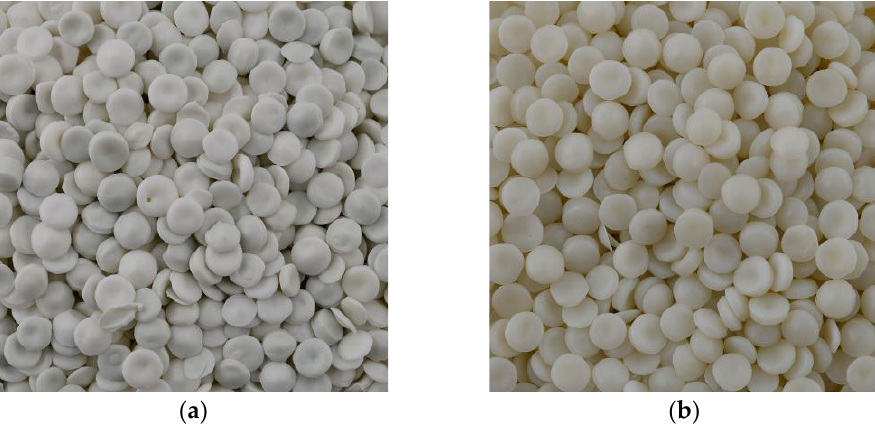
Figure 2. Images of the pellets of the PE-HD recyclates rPE-A in opaque white ( a ) and rPE-B in natural ( b ).